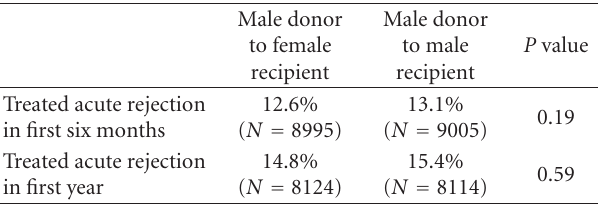
Table 3: Rate of treated acute rejection at six months and one year by donor recipient gender match.